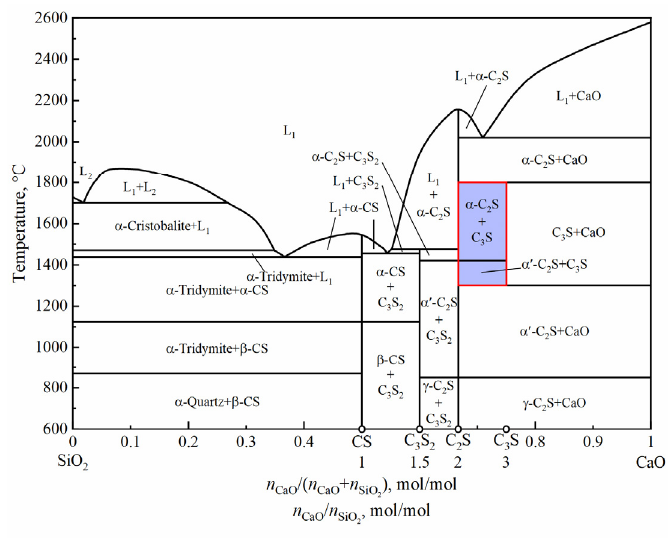
Figure 8. Binary phase diagram of CaO-SiO 2 [28].